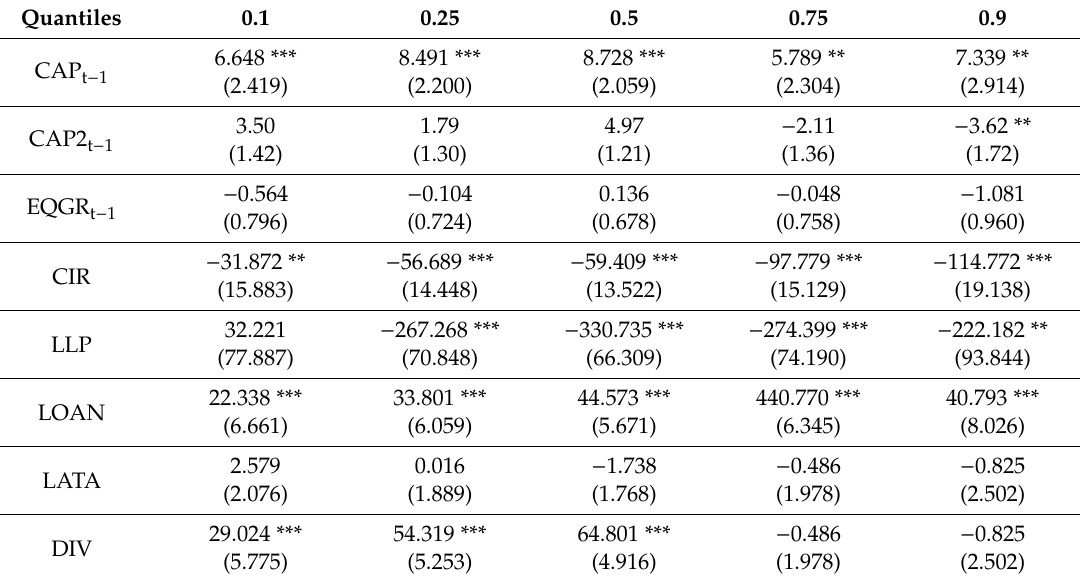
Table 6. The U-shaped relationship between capital ratio and